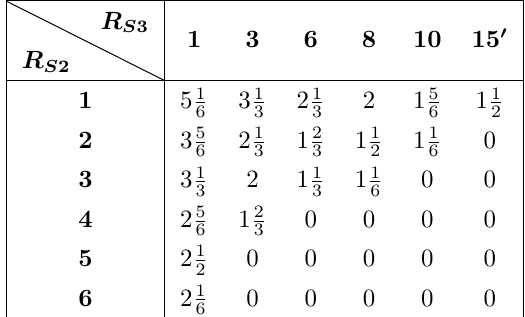
Table 4 . Maximal value of the hypercharge for which the SM gauge coupling g 1 remains pertur- bative up to 10 15 GeV . ( N = 1 and the scalar mass is set at 10 TeV ). S